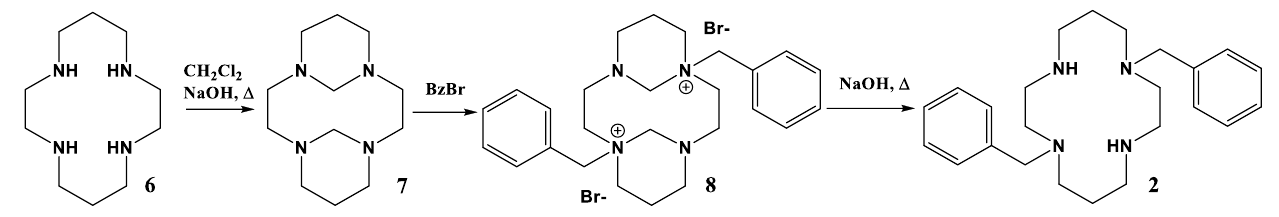
Figure 17. Synthetic scheme for 1,8-dibenzylcyclam ( 2 ).